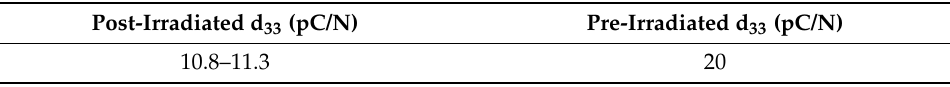
Table 2. d 33 readings of bismuth titanate sensors [14].